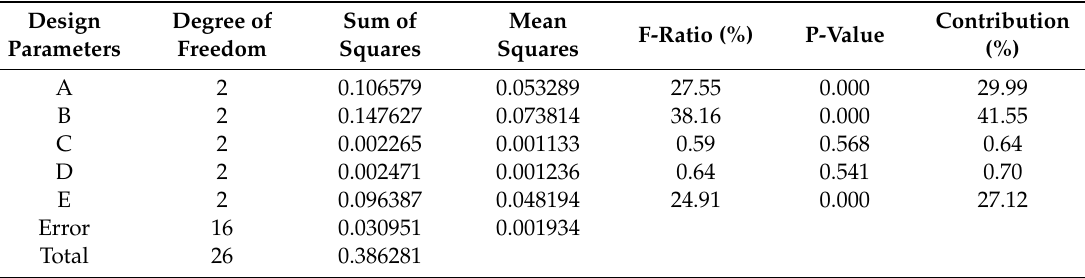
Table 8. Analysis of variance for